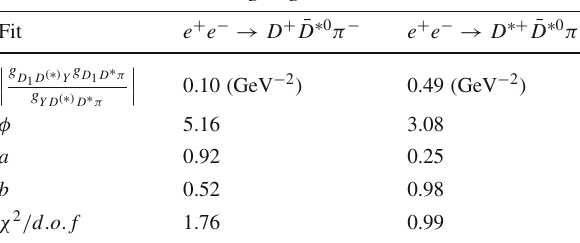
Table 1 The parameters for fitting the experimental line shape on the invariant mass spectrum of